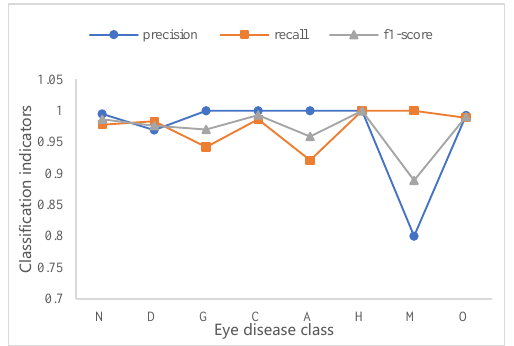
Figure 10. BFPC-Net test classification indicators for each disease.